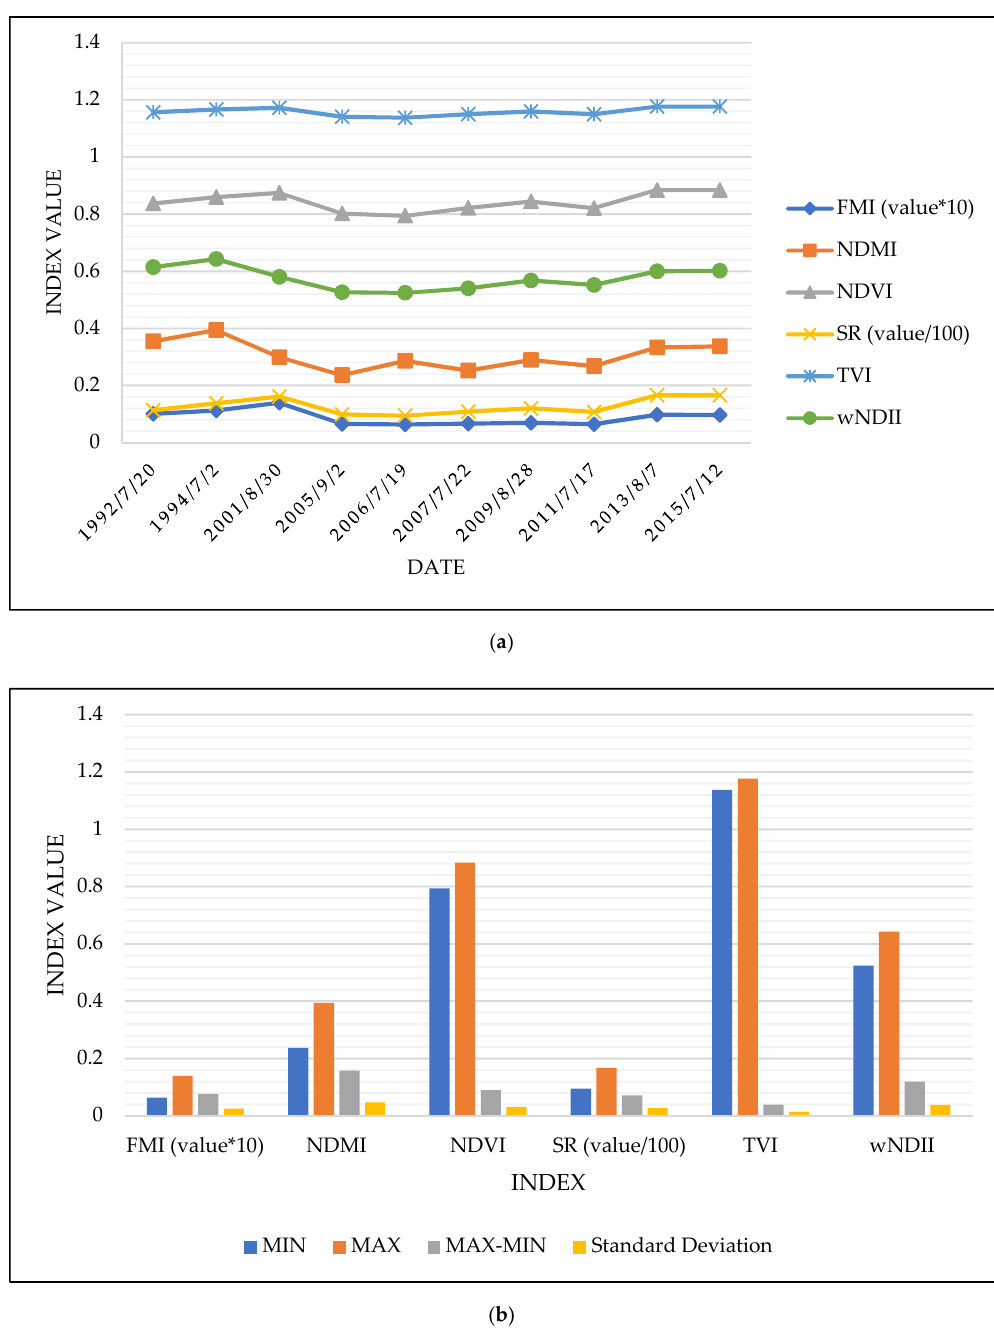
Figure 7. Time series of the vegetation indices for localities with minimal disturbance ( a ); and the statistical information ( b ) (Locality 3) (Source: Own work).